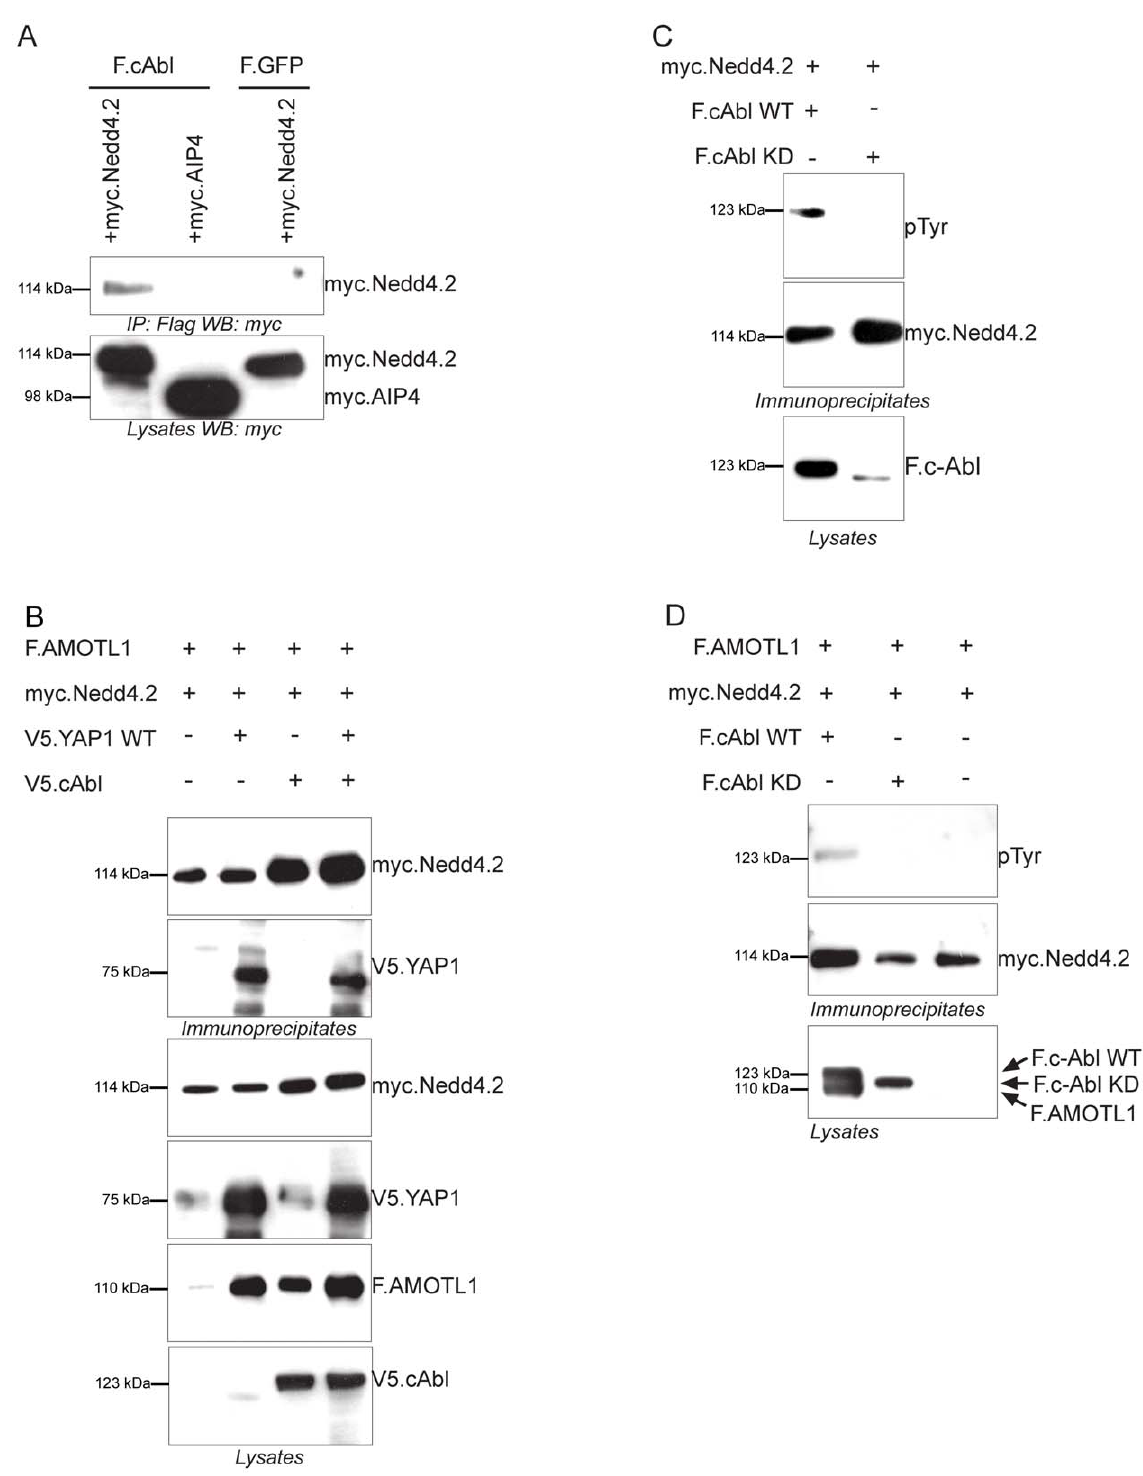
Figure 7. c-Abl phosphorylates Nedd4.2 which forms a triple complex with AMOTL1 and YAP1. A , Flag-tagged c-Abl (F.cAbl), immobilized on M2 sepharose beads, precipitates Nedd4.2. Immunoprecipitates were blotted with anti-myc antibody. AIP4, E3 ligase was used as a negative control. B , Protein-protein interactions among AMOTL1, Nedd4.2 and YAP1. HEK293T cells transfected with Flag-tagged AMOTL1, myc.Nedd4.2, V5.YAP1 and V5.cAbl plasmids were lysed and immunoprecipitation was performed using M2 beads. Precipitates were blotted with the antibodies indicated. Increased levels of AMOTL1 were detected in the presence of YAP1 and c-Abl. C , HEK293T cells were co-transfected with myc.Nedd4.2 and either wild type or kinase-dead (KD) c-Abl. Immunoprecipitation was performed with anti-myc antibody. Samples were blotted with anti-phosphotyrosine antibody to test for Nedd4.2 phosphorylation. D , Tyrosine phosphorylation of Nedd4.2 by c-Abl inhibits AMOTL1 degradation. Flag-tagged AMOTL1 (F.AMOTL1) and myc-tagged Nedd4.2 (myc.Nedd4.2) were co-expressed with either wild type or kinase-dead Flag-tagged c-Abl